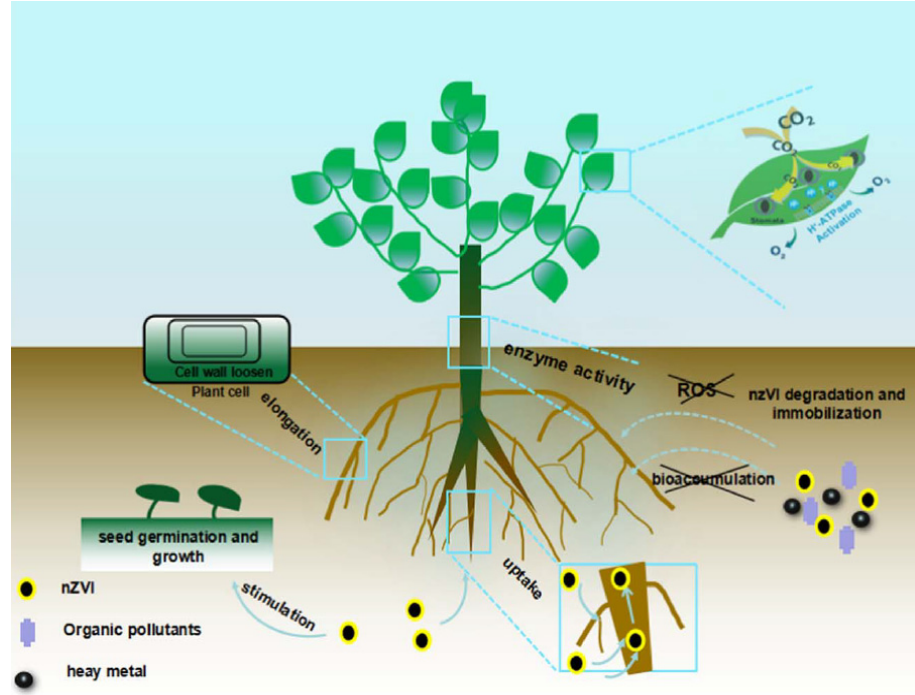
Figure 2. Conceivable impact of nZVI particles on plants. Reproduced with permission from [87], Elsevier, 2018.